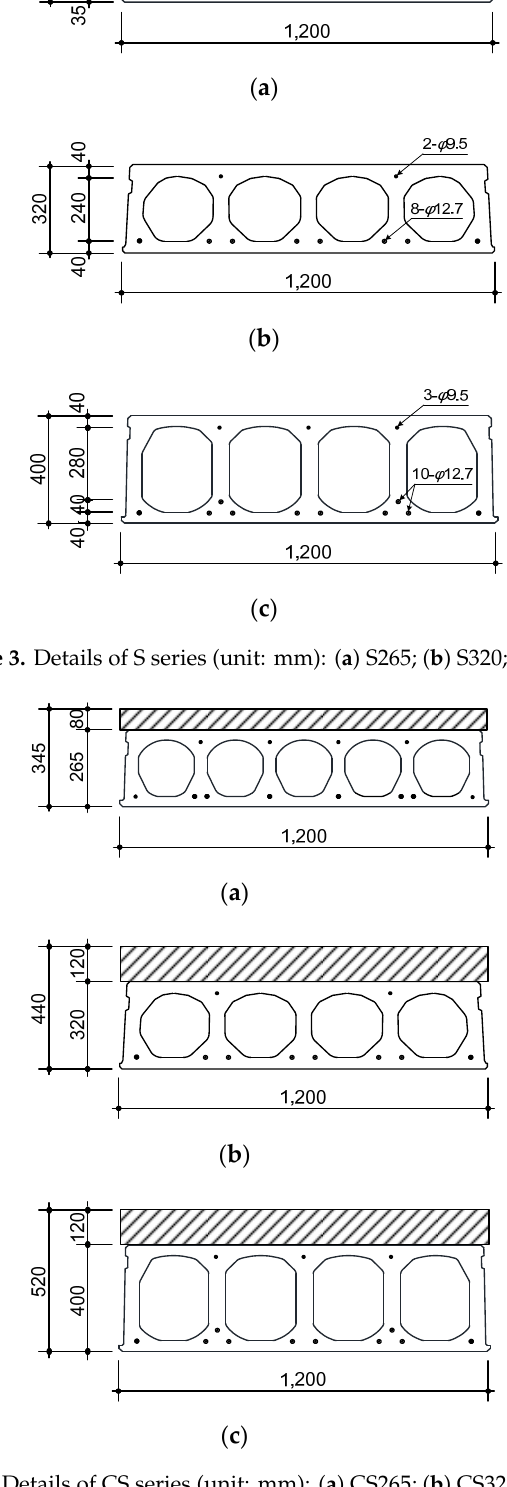
Figure 4. Details of CS series (unit: mm): ( a ) CS265; ( b ) CS320; ( c ) CS400.